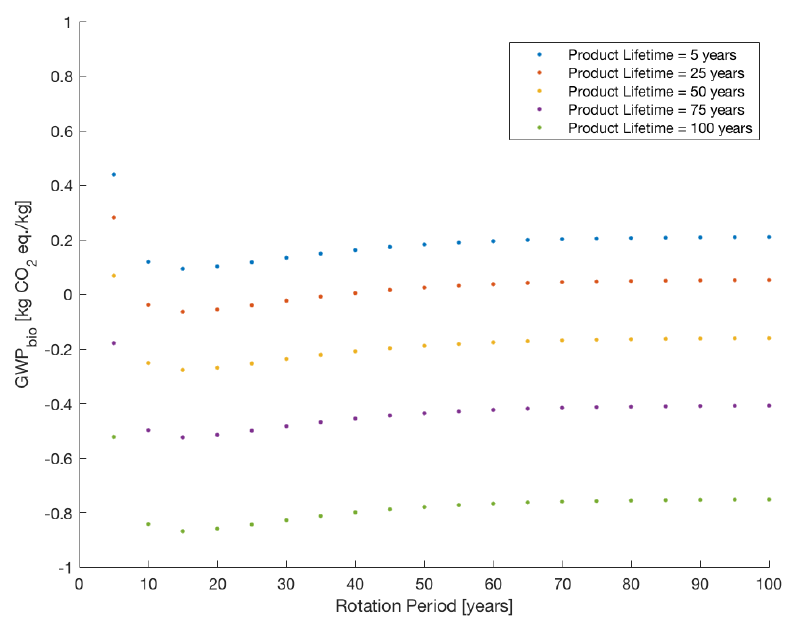
Figure 2. Overlay plot of curves representing the evolution of GWP bio with respect to biomass rotation period for various product lifetimes.